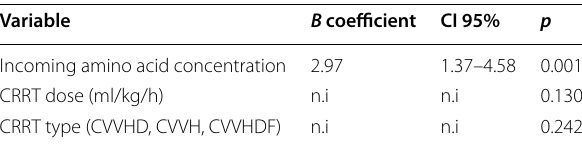
Table 1. Multivariate regression